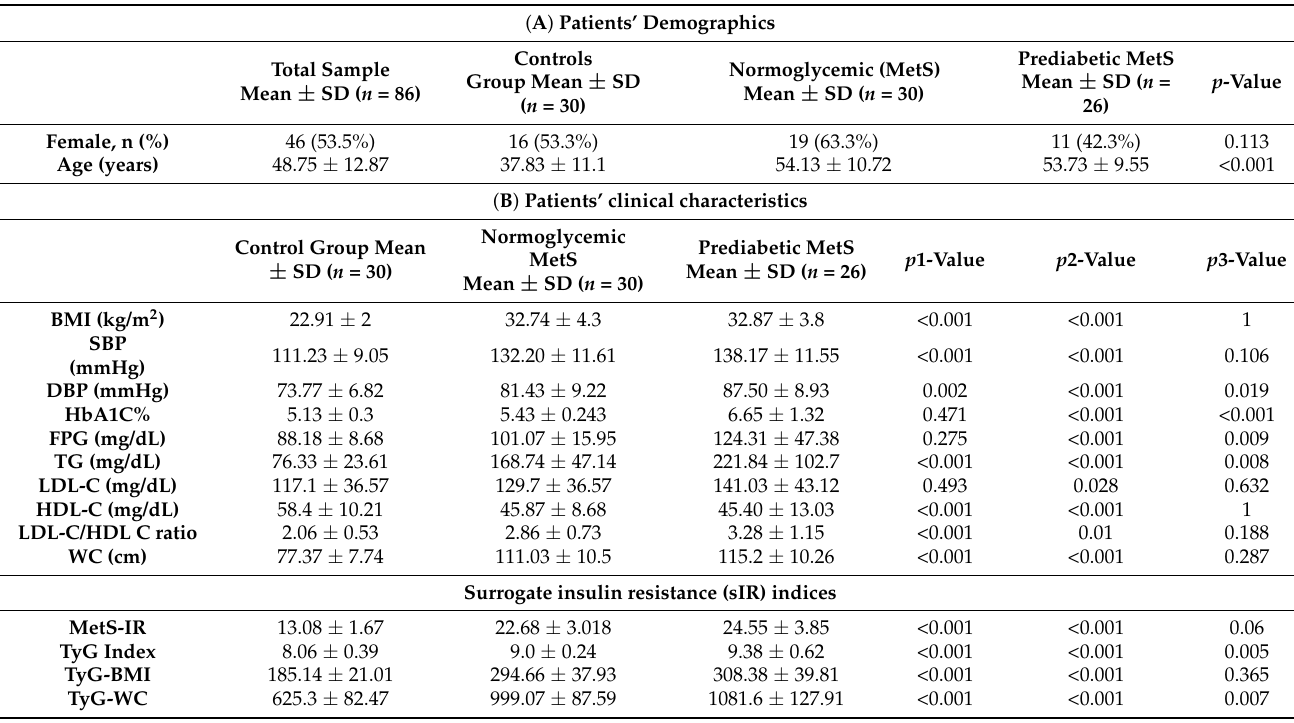
Table 1. Patients’ demographic ( A ) and clinical characteristics ( B ). ( A ) Patients’